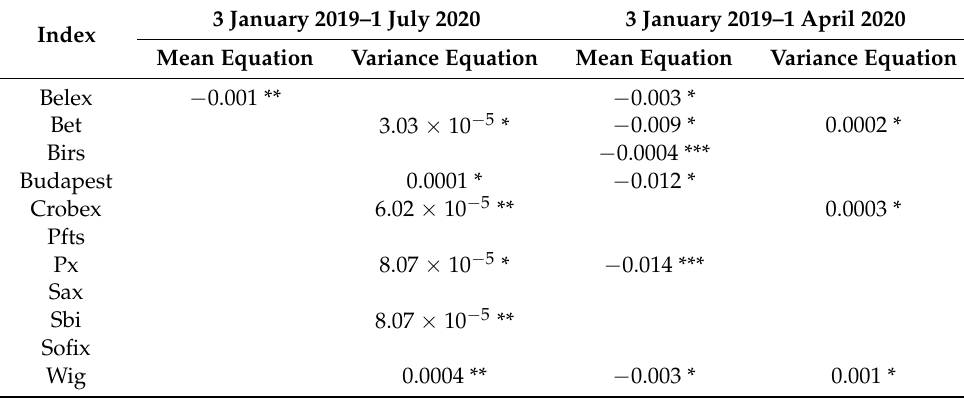
Table 8. Significance of binary variable